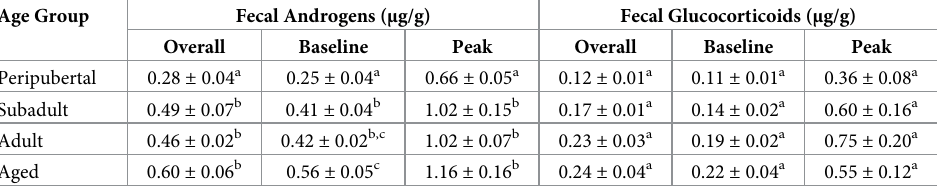
Table 2. Overall, baseline and peak mean ( ± SE) concentrations of fecal androgen and glucocorticoid metabolites by age group. Age Group Fecal Androgens ( μ g/g) Fecal Glucocorticoids ( μ g/g)